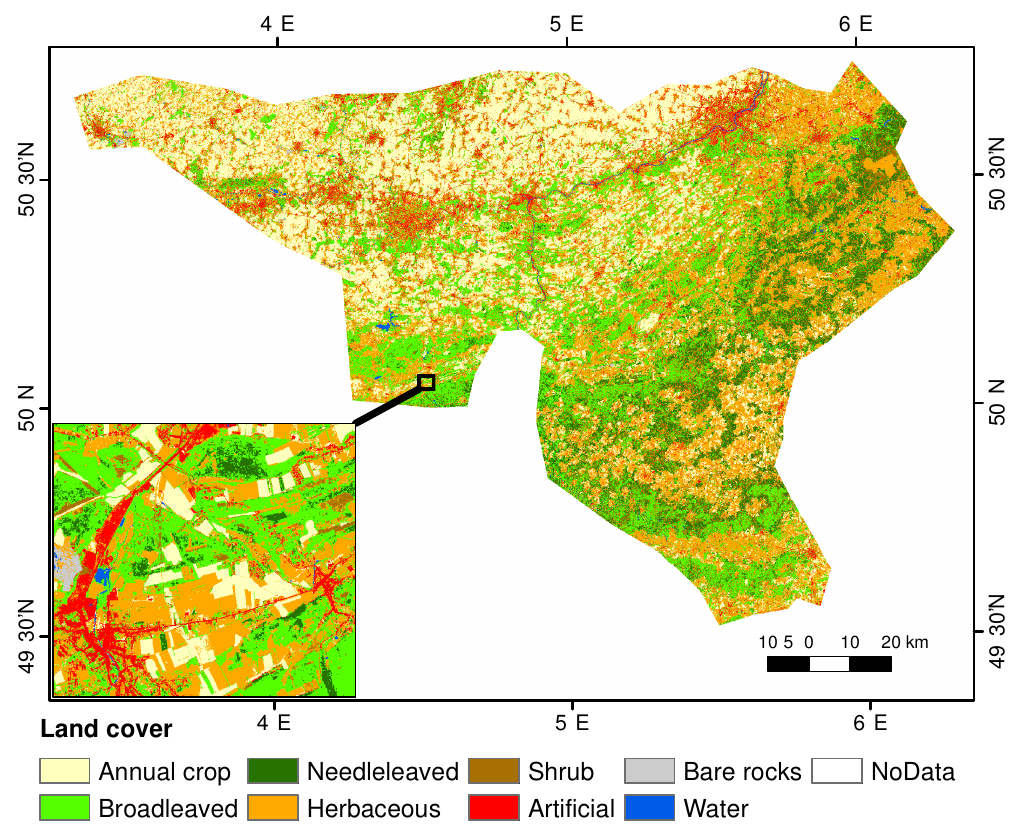
Figure 2. Land cover information used as a virtual truth to illustrate the